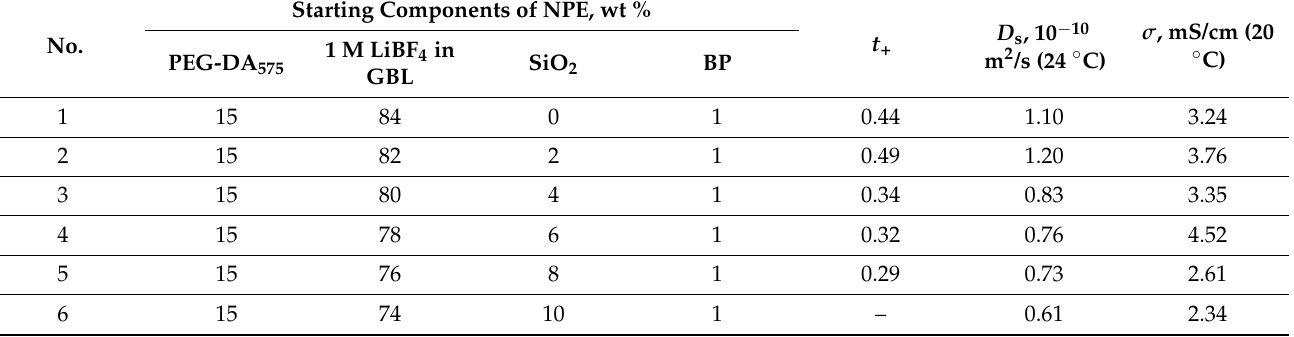
Table 10. Parameters of ion transport for different NPE compositions: conductivity ( σ sp ) at 20 ° С ,